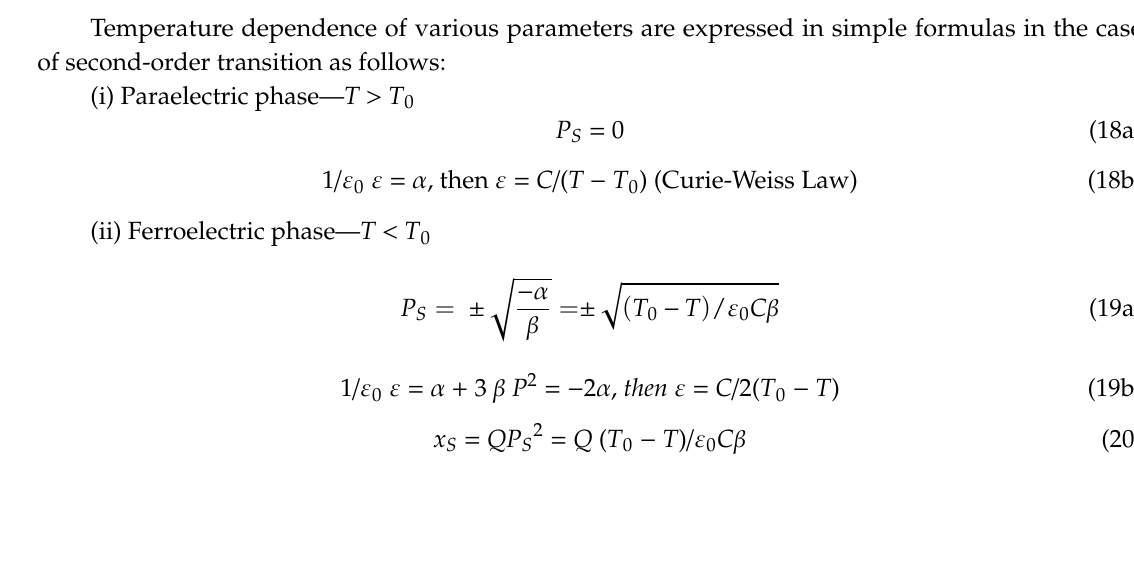
Figure 3. Phase transitions in a ferroelectric: ( a ) second-order and ( b ) first-order transition.